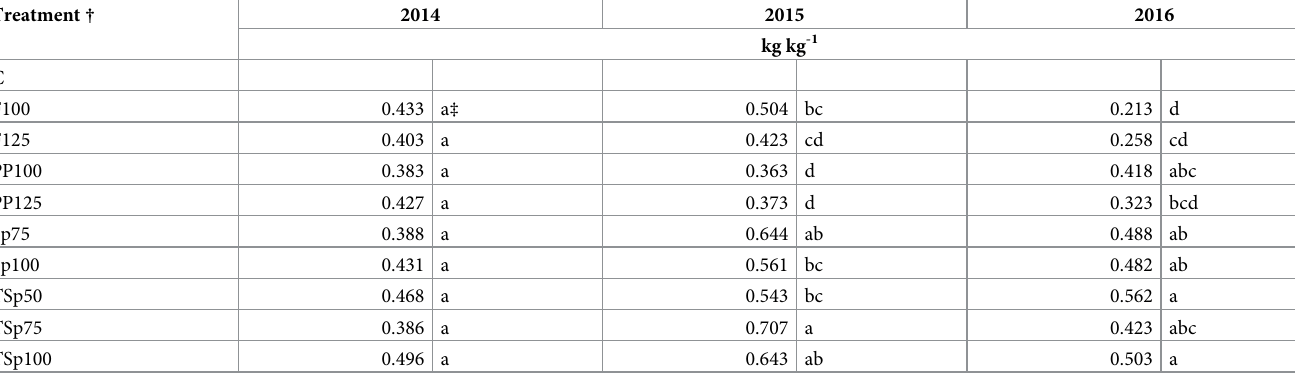
Table 11. Recovery efficiency of applied N fertilizer as affected by treatment and year, averaged across locations. Treatment